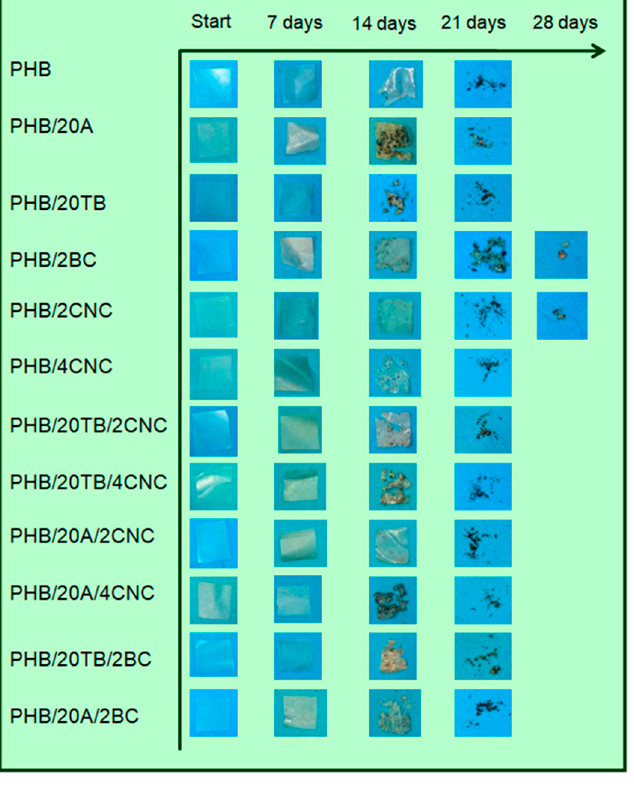
Figure 8. Visual appearance of PHB nanocomposites at different incubation times under composting conditions.